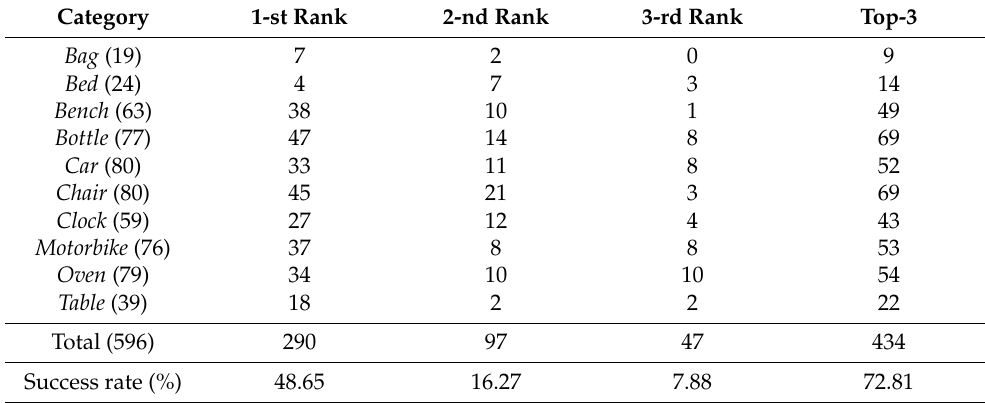
Table 1. CAD model retrieval results using the similarity measurement SM1.